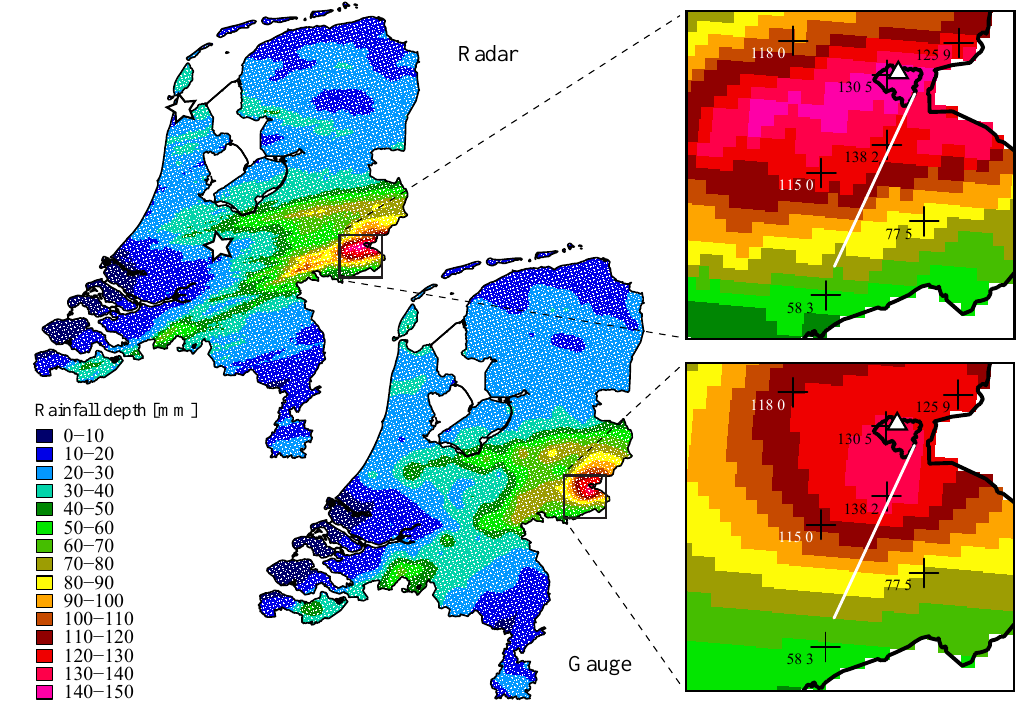
Fig. 2. Daily rainfall depths for 26 August, 08:00UTC to 27 August, 08:00UTC for The Netherlands and the region around the Hupsel Brook catchment. Upper panels: depths for the gauge-adjusted radar composite. Lower panels: depths for the interpolated manual rain gauge data. Also plotted are: weather radars (stars), manual rain gauges and their daily rainfall depths (plusses), automatic rain gauge (triangle), and microwave link path (line). Because the automatic rain gauge at Hupsel stopped recording at 21:00UTC no daily rainfall depth was plotted for this